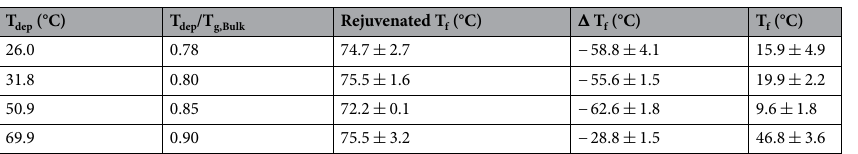
Table 1. Fictive temperatures and fictive temperature reductions for stable CYTOP films deposited at different substrate temperatures. All Cooling rates were 0.167 K/s (10 K/min) and all heating rates were 600 K/s. (cid:31) T f value is relative to the rejuvenated T f